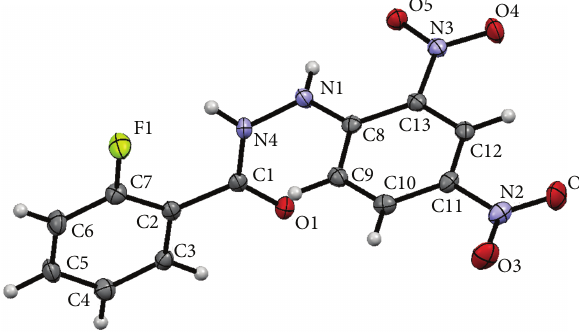
Figure 1: The molecular structure of the title molecule ( 1 ), showing the atom-numbering scheme. Displacement ellipsoids are drawn at the 50% probability level, and H atoms are shown as small spheres of arbitrary radii.